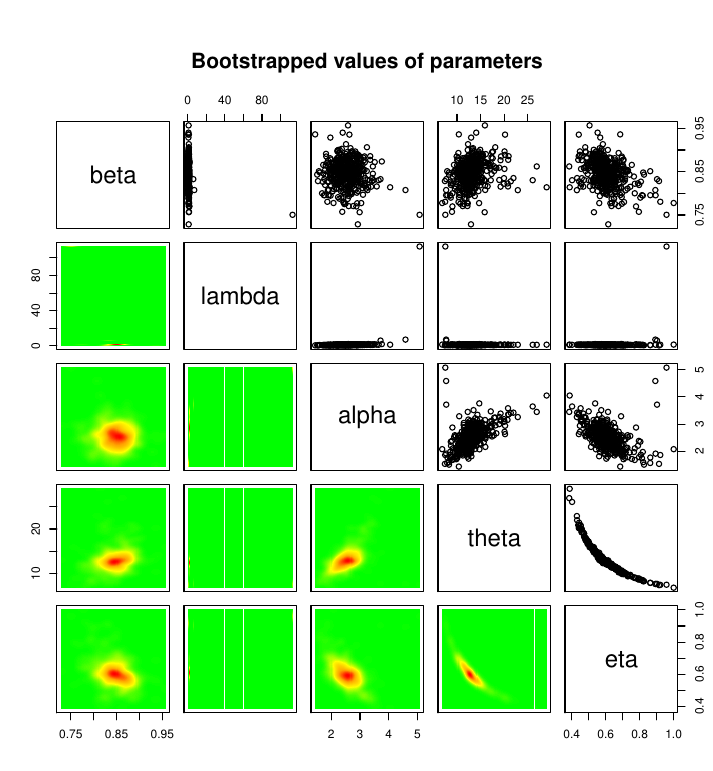
Figure 6 – Non-parametric bootstrapped values of parameters of GOTTS-E distribution for the first data